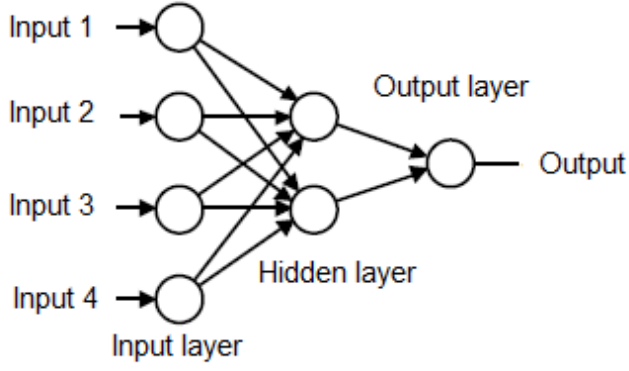
Figure 5. Basic structure of the artificial neural network [41,42].